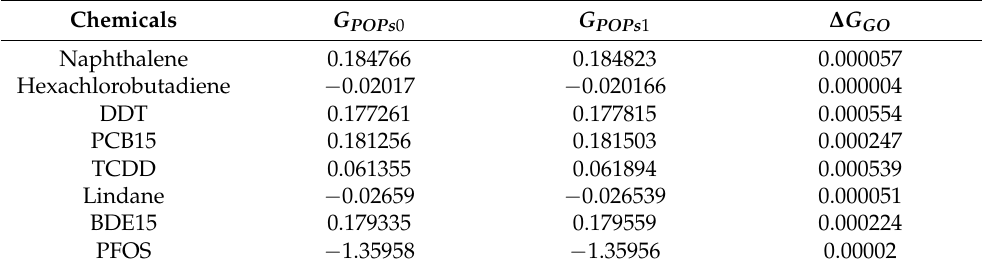
Table 4. Gibbs free energy of POPs